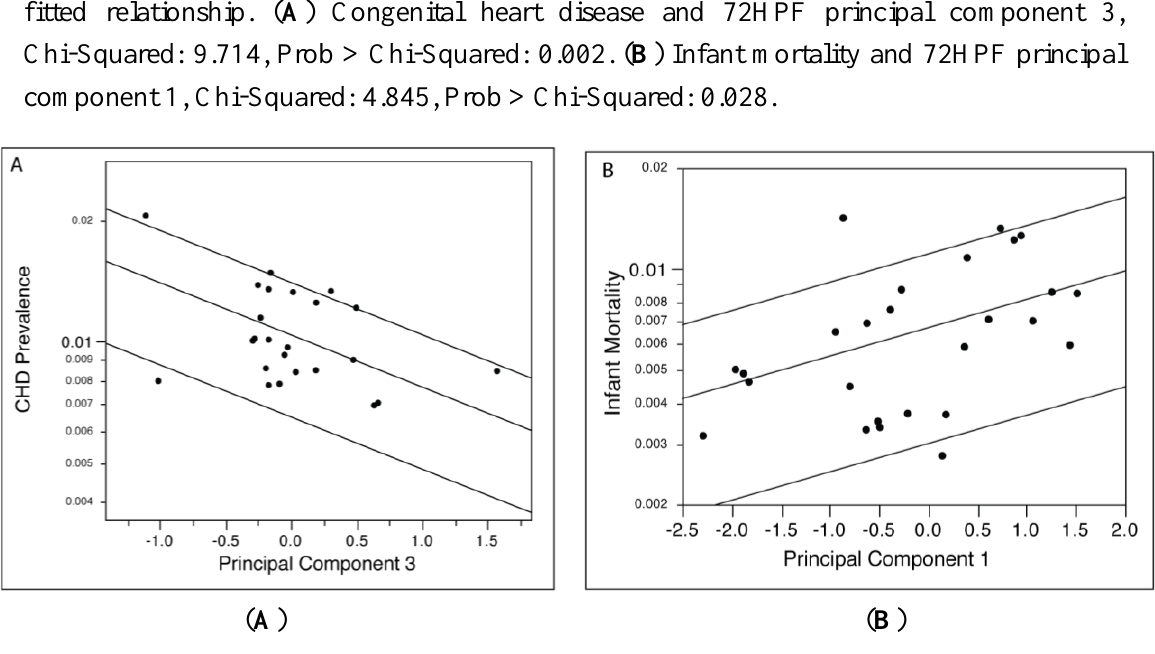
Figure 5. Risk-regression of STT ELS principal components and prevalence of birth outcomes. Prevalences are calculated as incidence of death within first year of life, or diagnosis of congenital heart disease, divided by total births for that time period in the corresponding city or ZIP code. Lines represent the 10th, 50th, and 90th percentiles of the fitted relationship. ( A ) Congenital heart disease and 72HPF principal component 3, Chi-Squared: 9.714, Prob > Chi-Squared: 0.002. ( B ) Infant mortality and 72HPF